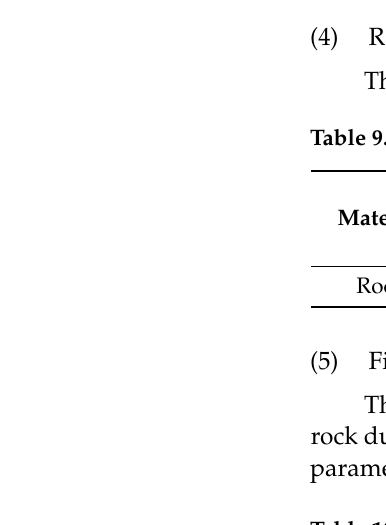
Table 10. Calculation parameter table of filling